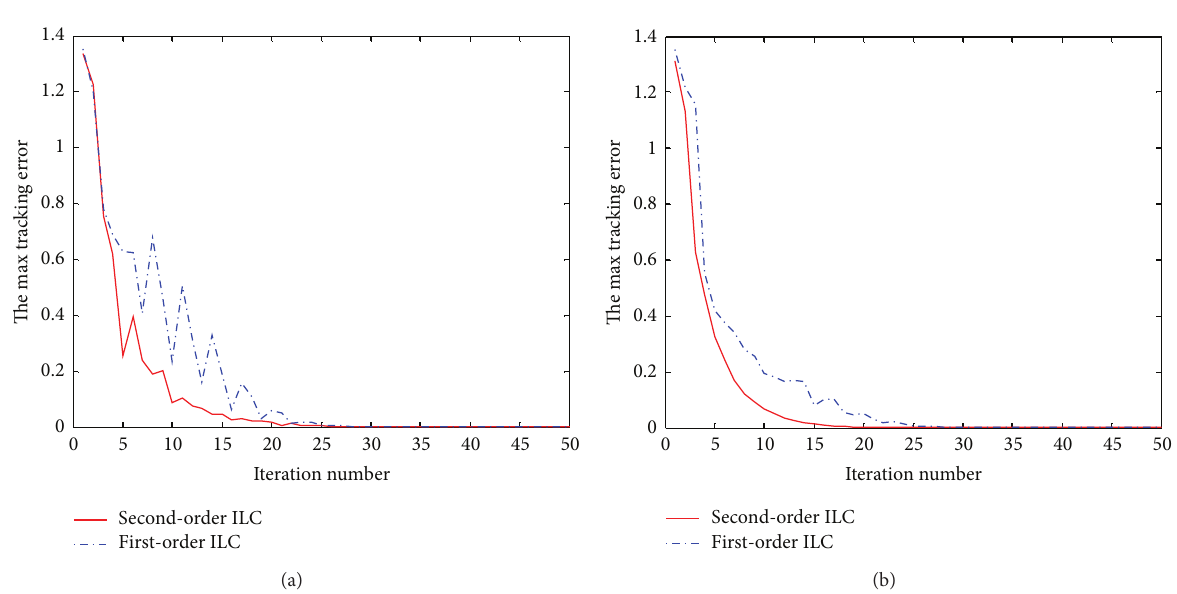
Figure 10: The max tracking error of Example 2 for different ILC laws: (a) 𝑒 1,𝑘 (𝑡) , (b) 𝑒 2,𝑘 (𝑡)